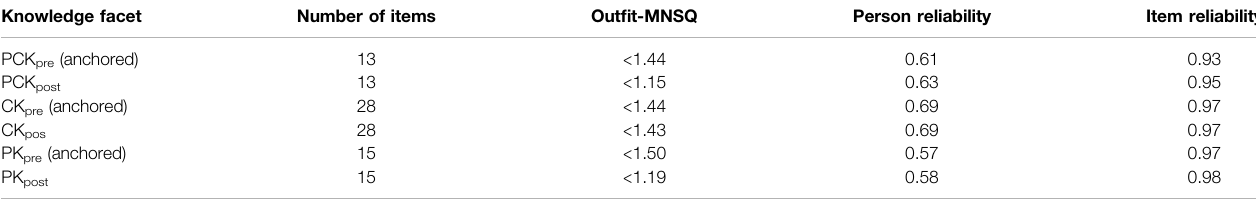
TABLE 5 | Fit statistics of the professional knowledge tests using Rasch analysis techniques and the Rasch partial credit model. Knowledge facet Number of items Out fi